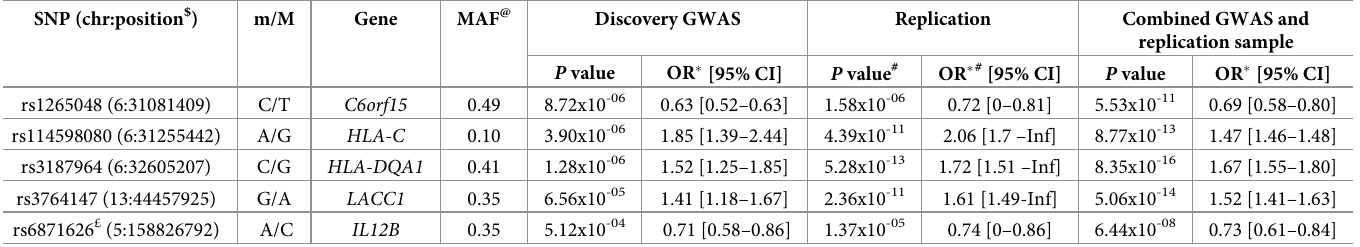
Table 2. Association statistics in the discovery GWAS, the case/control replication and the combined GWAS and replication samples for the five independent SNPs identified by multivariate analysis. SNP (chr:position $